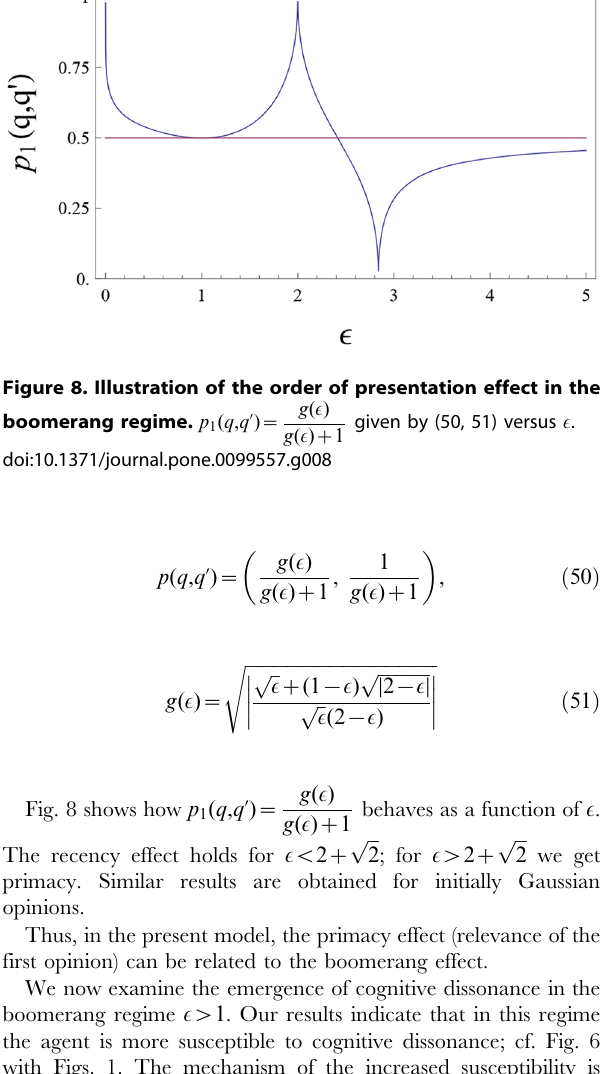
Fig. 8 shows how p 1 ( q , q ’ ) ~ The recency effect holds for E v 2 z